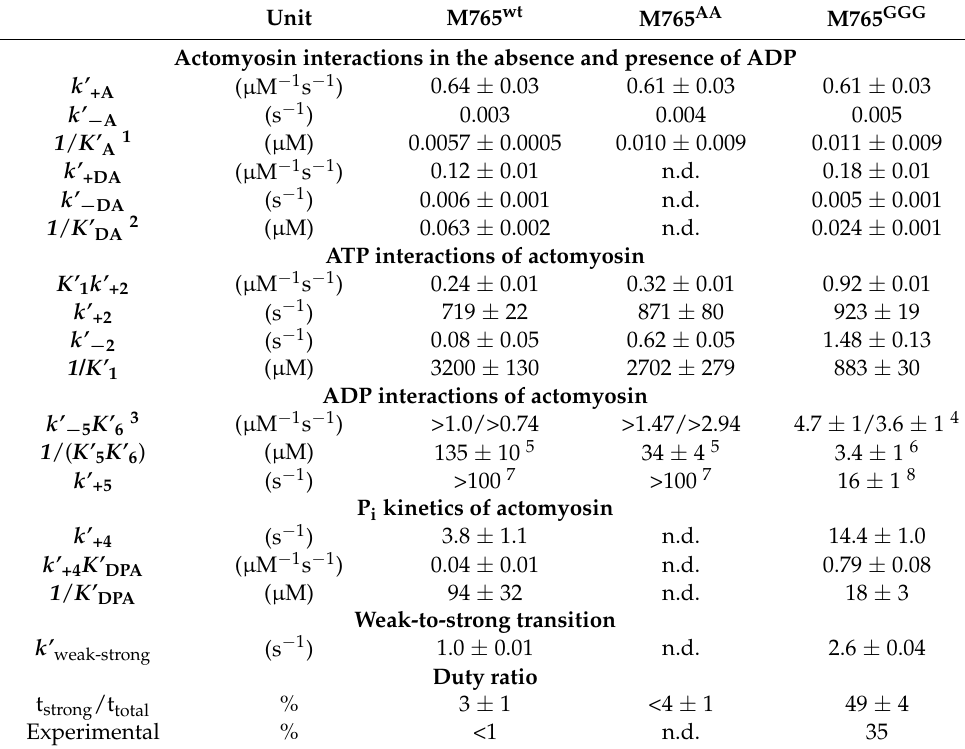
Table 4. Transient kinetic parameters and equilibrium constants in the presence of